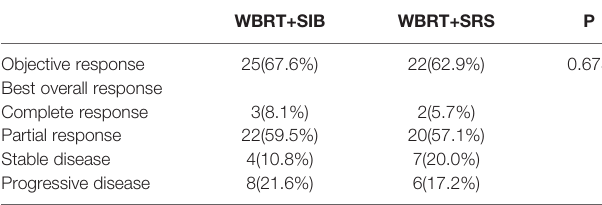
TABLE 2 | Overall response according to RECIST1.1 criteria.